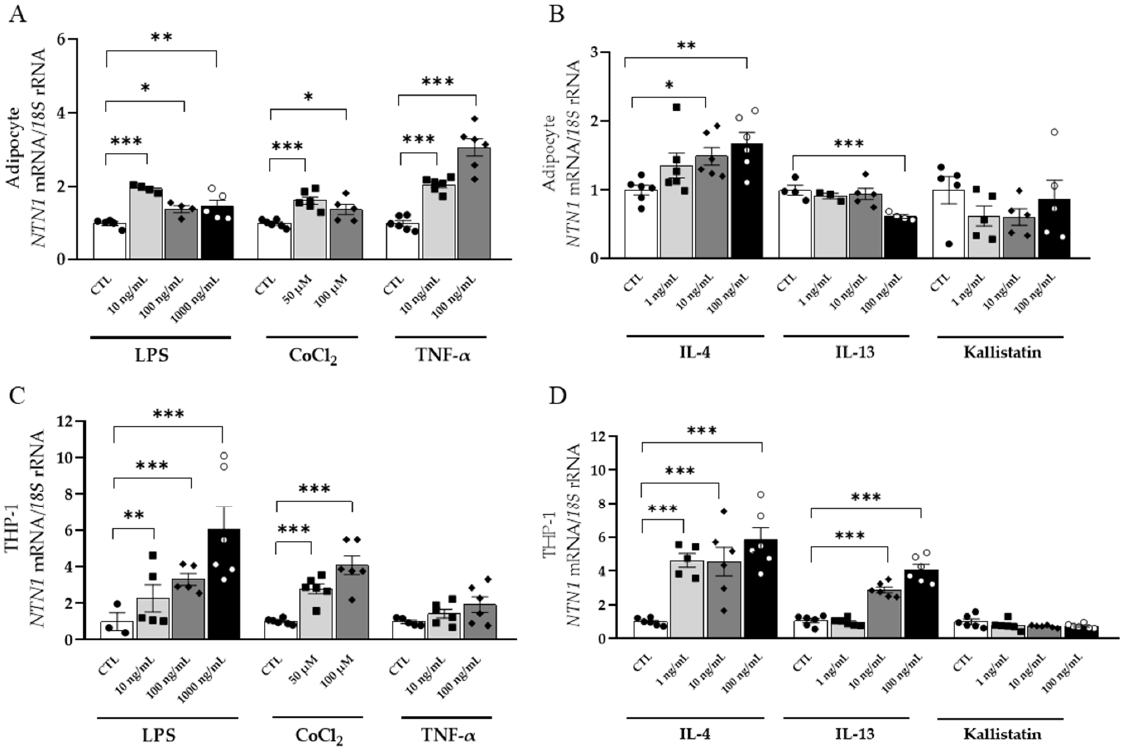
Figure 3. ( A , C ) Effect of the pro-inflammatory factors LPS, CoCl 2 and TNF- α and ( B , D ) the anti- inflammatory mediators IL-4, IL-13, and kallistatin on NTN1 gene expression levels in human differentiated visceral adipocytes and monocyte-derived macrophages. Gene expression levels in unstimulated cells were assumed to be 1. Differences between groups were analyzed by one-way ANOVA followed by Dunnett’s post hoc tests. * p < 0.05, ** p < 0.01, and *** p < 0.001. CTL, control. Interestingly, we found increased mRNA levels of NTN1 ( p < 0.01) in THP-1-derived macrophages treated with 20% and 40% ACM, but no differences in NEO1 expression levels were detected (Figure 4).